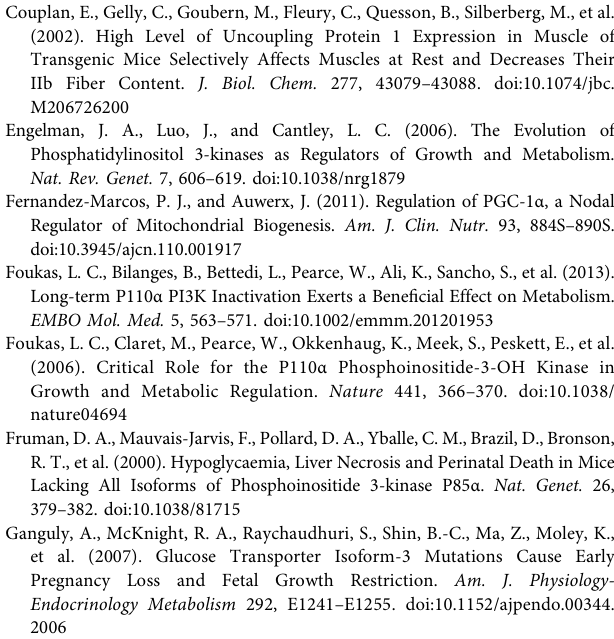
Supplementary Figure S1 | Study design. Abbreviations: bp (base pairs), GTT (glucose tolerance test), ITT (insulin tolerance test), NP (non-pregnant), WT (wildtype). Gestational length in mice ~ 20 days. Supplementary Figure S2 | Raw values for glucose and insulin tolerance tests (GTT, ITT) and homeostatic model assessment (HOMA) models. (A,B) Glucose values not normalized to baseline (time 0). ( n =4 – 5/group; data analysed by two-way repeated measures ANOVA). #,*, @ de fi ned within the fi gure. (C,D) . HOMA models for insulin resistance (HOMA-IR) and β -cell function (HOMA- β ) ( n =4 – 5/group; two- way ANOVA). Abbreviations NP (non-pregnant), P (pregnant). Supplementary Figure S3 | Main fi ndings of the